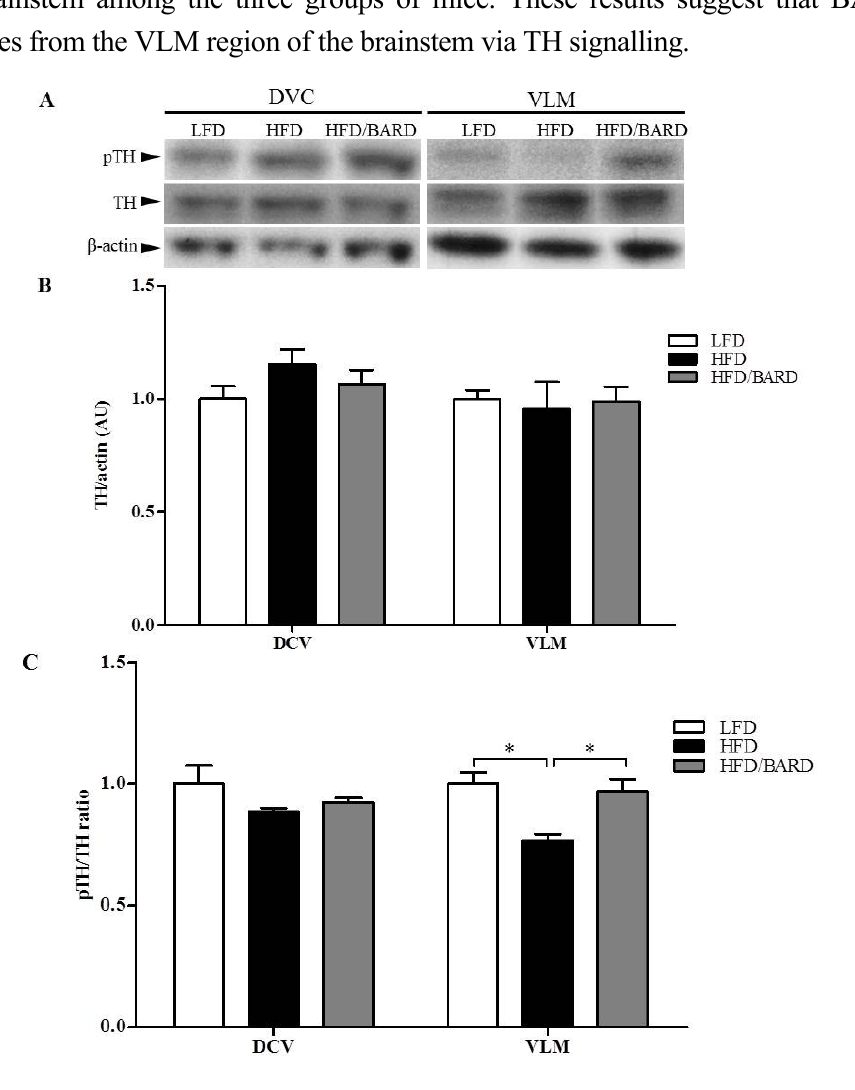
Figure 5. Effect of bardoxolone methyl (BARD) on noradrenergic activation in the brainstem of mice fed: low-fat diet (LFD), high-fat diet (HFD), and high-fat diet supplemented with BARD (HFD/BARD). ( A ) Representative blots; ( B ) Total TH protein; ( C ) pTH/TH ratio. All data are mean ± SEM. * p < 0.05. TH: tyrosine hydroxylase; pTH: phosphorylated tyrosine hydroxylase; DVC: dorsal vagal complex; VLM: ventrolateral medulla; AU: arbitrary